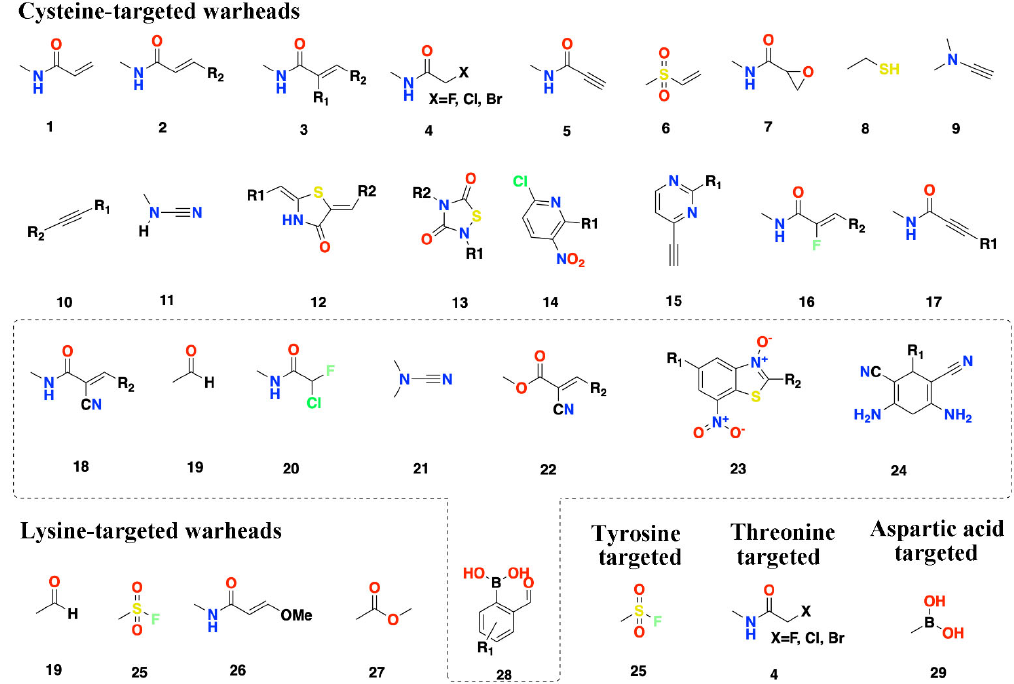
Figure 2. Warheads present in available covalent kinase inhibitors. Warheads are grouped based on different targeted amino acids. The dashed rectangle shows the warheads found in reversible CKIs.